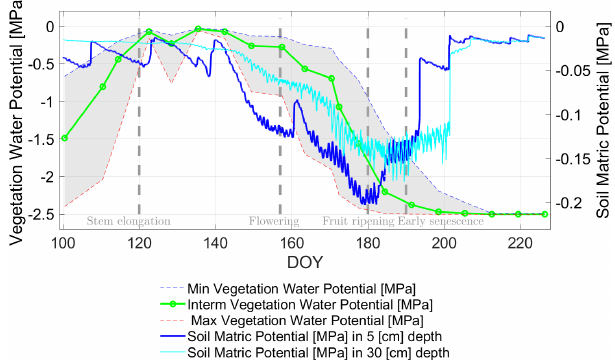
Figure 11. Seasonal relative water content (RWC Season ) [%] calcu- lated in Eq. (2) with radiometer-derived m g (green circles) along the growing season of 2017 in days of year (DOY) at the winter wheat field in Selhausen, Germany. The gray circles indicate RWC Season calculated directly with the radiometer-derived vegetation optical depth (VOD) according to Eq. (9).